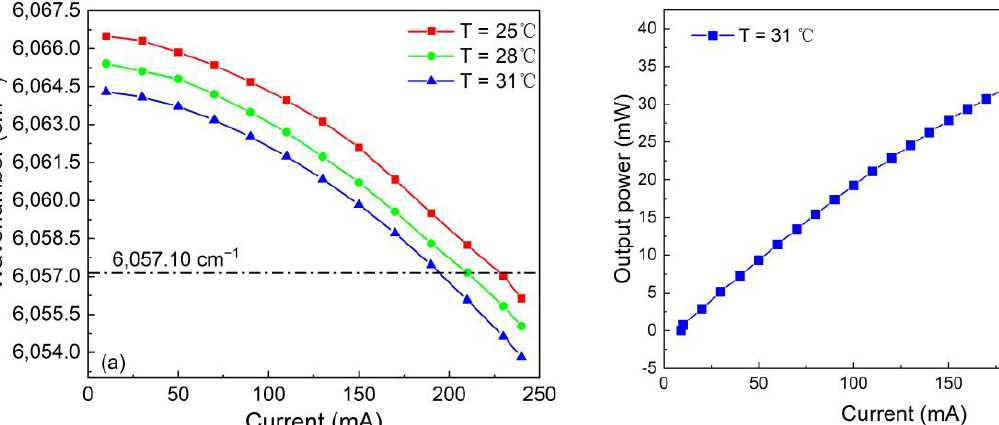
Figure 2. Absorption lines of CH 4 , H 2 O and CO 2 at the conditions of 1 atm pressure, 296 K temperature and 1 cm optical absorption length using the database of HITRAN 2016.